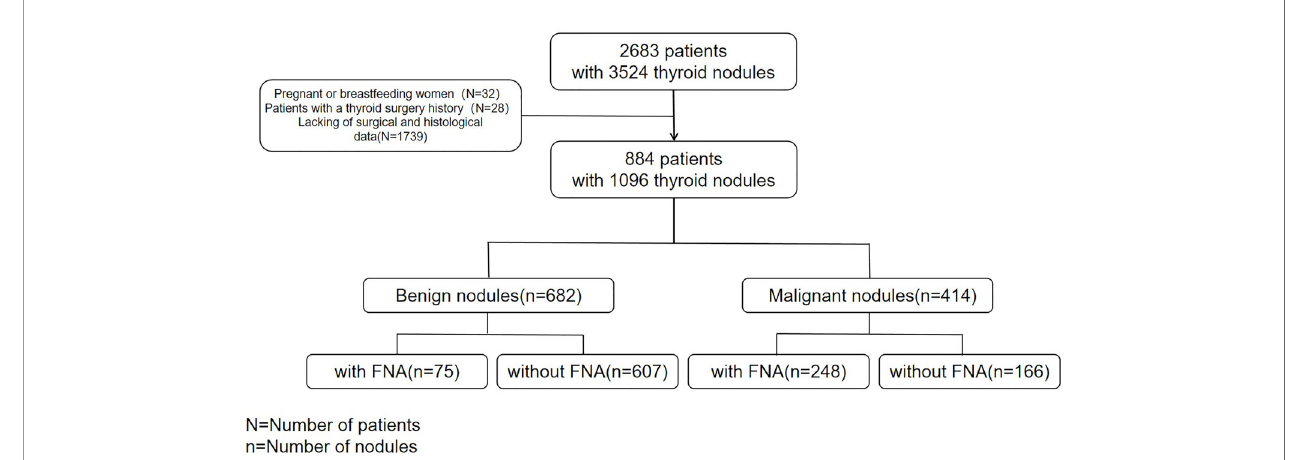
FIGURE 1 | Flowchart of